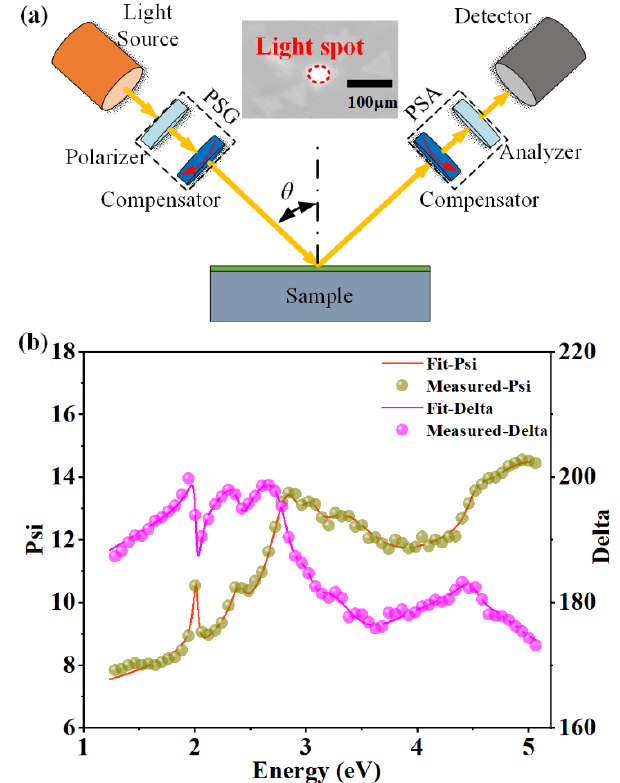
Figure 3. ( a ) Schematic of the spectroscopic ellipsometer, the inset shows the CCD image of light spot irradiated on the sample. ( b ) Measured and best-fitting ellipsometric spectra (Ψ, Δ) of monolayer WS 2